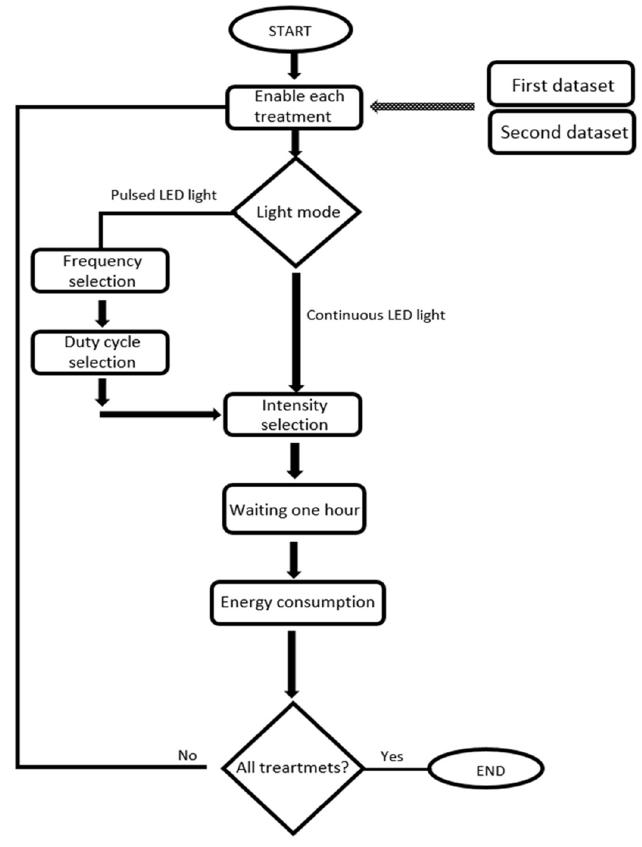
Figure 2. Detailed procedure for data collection.